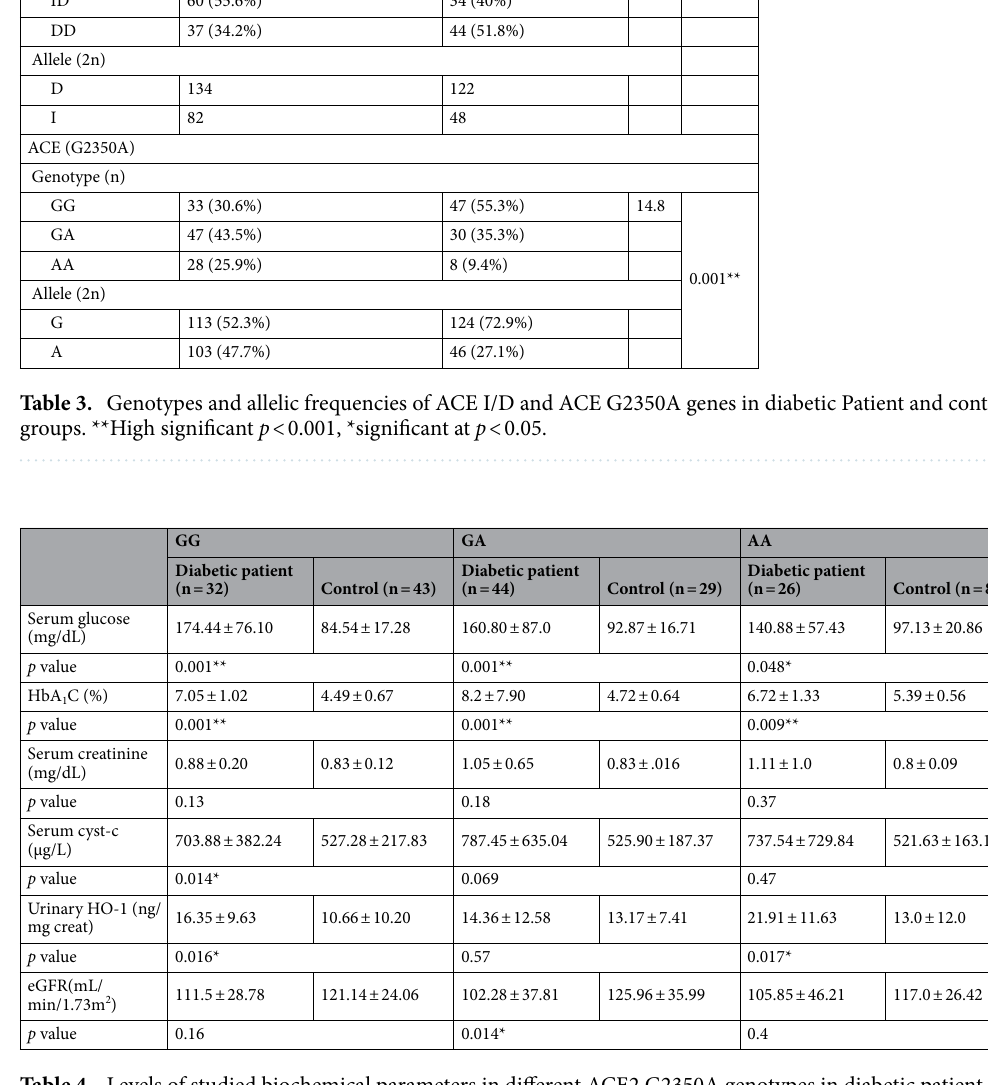
Table 4. Levels of studied biochemical parameters in different ACE2 G2350A genotypes in diabetic patient and control groups. **High significant p < 0.001, *significant at p <